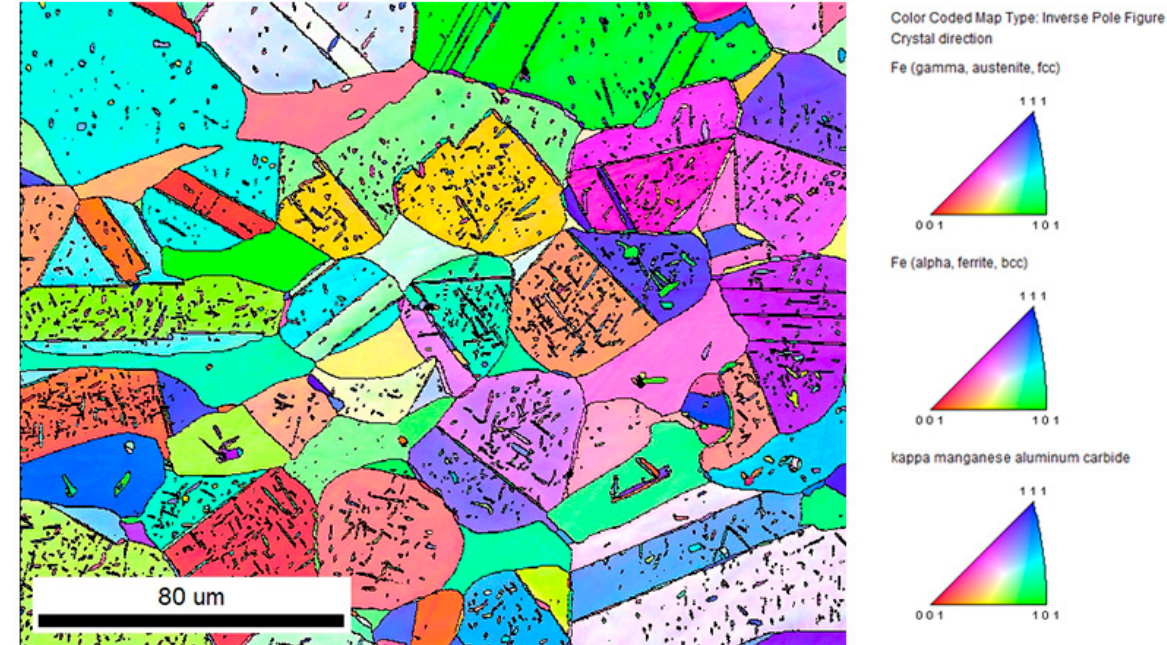
Figure 14. Electron backscattered diffraction analysis of a sample annealed at 850 °C showing different orientations of austenite with precipitated B2 ordered phase, along grain boundaries, on twins and intracrystalline.